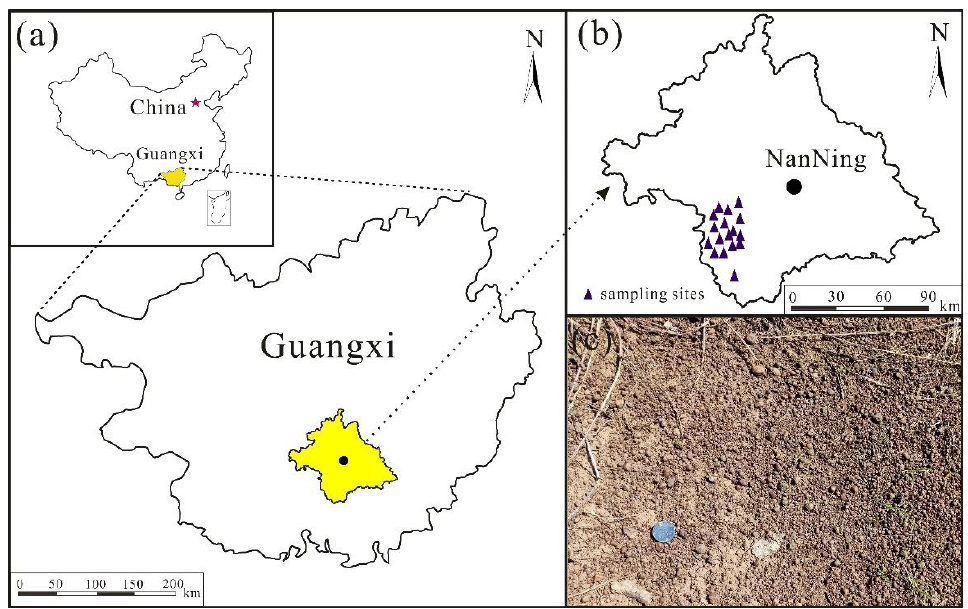
Figure 1. Map showing the study area in China ( a ), locations of the sampling sites ( b ), and image of the soil surface ( c ).